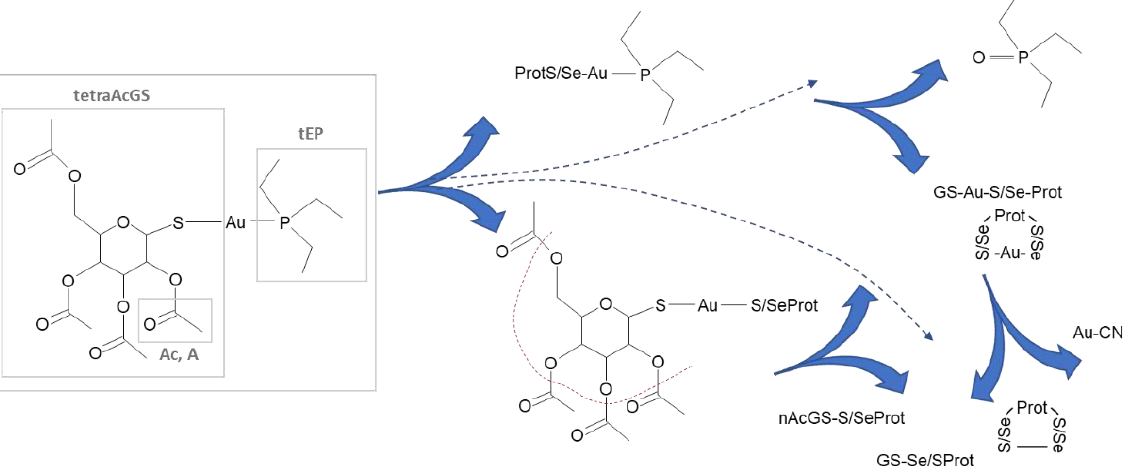
Figure 1. Structure of 2,3,4,6-tetra-O-acetyl-1-thio- β -D-glucopyranosato-S) (triethylphosphine) gold(I) known as auranofin and most commonly reported/postulated products of its transfor- mations.